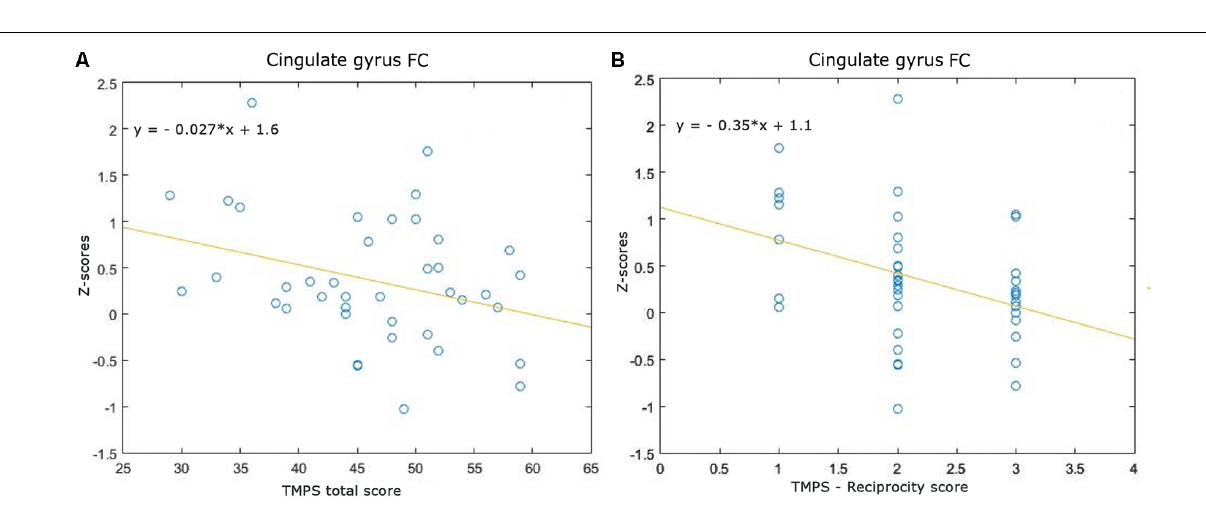
(rho = − 0.309, p = 0.0493; Figure 4 ). No correlations were found between social cognition tasks and RFPN, LFPN, and SLN RS-FC abnormalities. In the HC group, reciprocity subscale of TMPS was also negatively correlated with abnormalities in the right middle temporal gyrus in DMN (rho = − 0.4668, p = 0.0186), while first-order ToM subscale of TMPS was positively correlated with FC in the right precentral gyrus in the EN (rho = 0.3958, p =